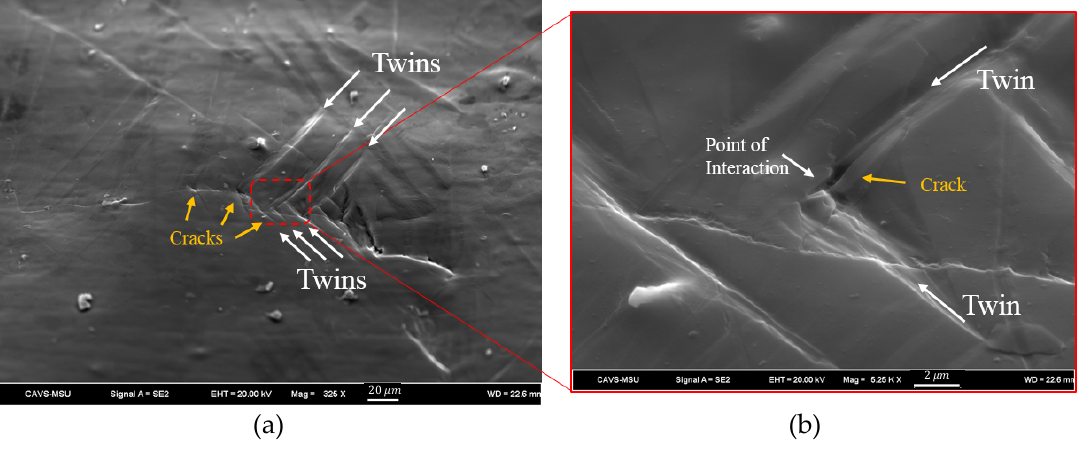
Figure 9. Micrographs of ( a ) { 1012 } twin–twin interactions and ( b ) their involvement in crack nucleation viewed through zoomed image of the dashed red region in ( a